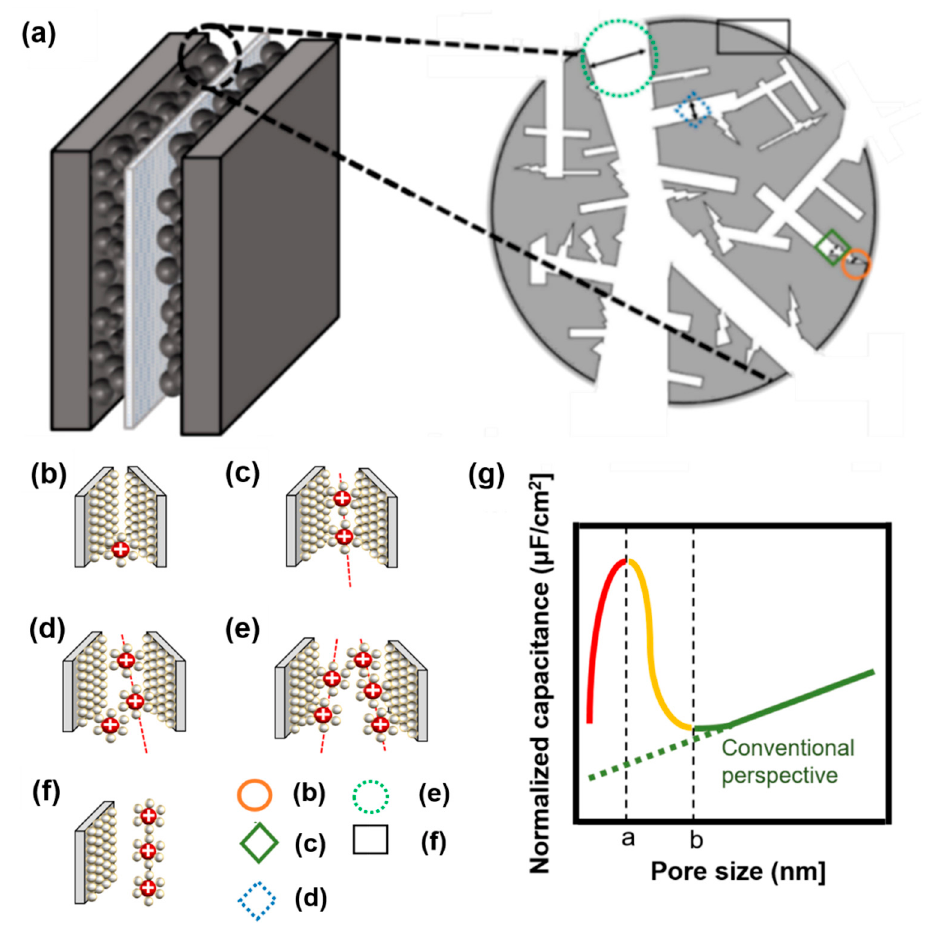
Figure 4. ( a ) Brief structure of activated carbon particles with various pore sizes, not based on a circle, but based on the electrode theory of walls and walls. ( b ) Nanopores do not have the minimum space required to form an electrical layer with solvated ions, ( c ) nanopores have minimal space to form an electrical layer with solvated ions, ( d ) nanopores have extra space to form an electrical layer with solvated ions, ( e ) nanopores have sufficient space for each electrode such that solvated ions can form an electrical layer with each electrode, ( f ) electric layer for carbon grain at the surface, ( g ) schematic diagram of normalized capacitance according to pore size. When the pore size is less than or equal to a , which is indicated by a red-colored line, ( b , c ) is applicable, and when the pore size is more than a and less than or equal to b , which is indicated by a yellow-colored line, ( c , d ) is applicable. If the pore size is larger than b, which is indicated by a green-colored line with a conventional view, ( e , f ) is applied [25,39,40,42].